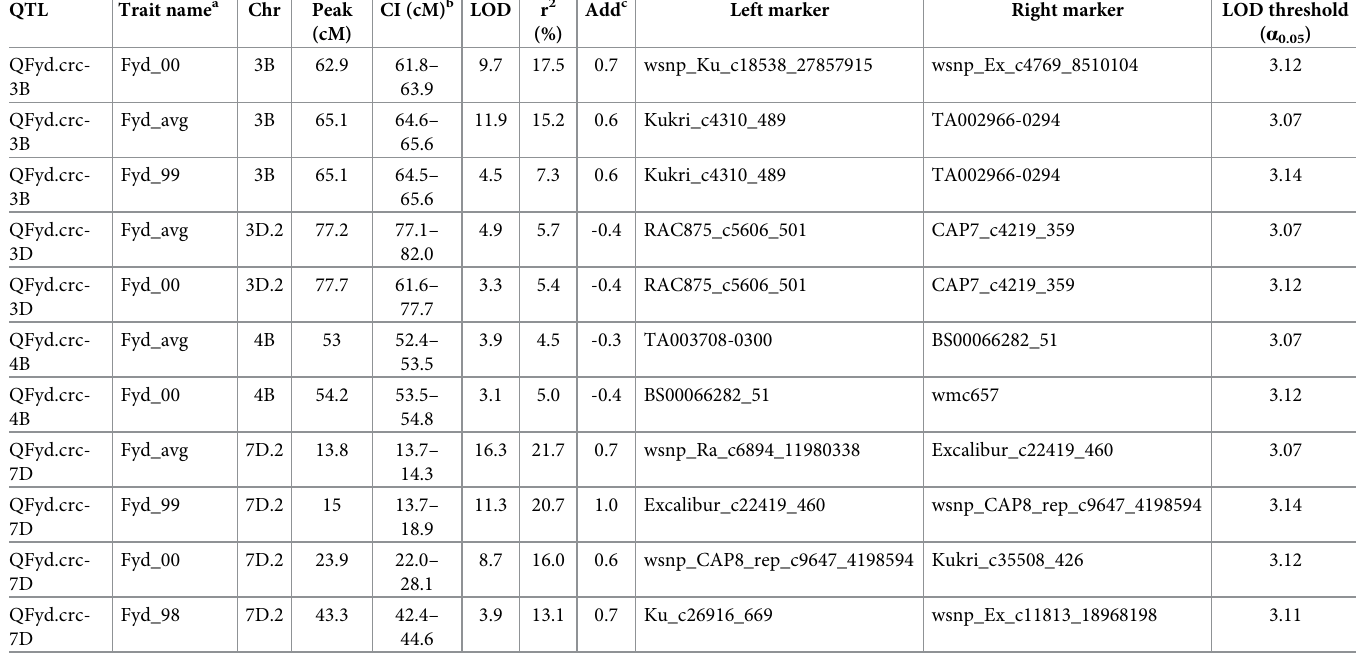
Confidence interval determined by one LOD drop-off. c Additive effect of allele substitution. The units are those of the respective trait. A positive sign indicated that the ‘AC Domain’ allele increased the respective quantitative trait, and